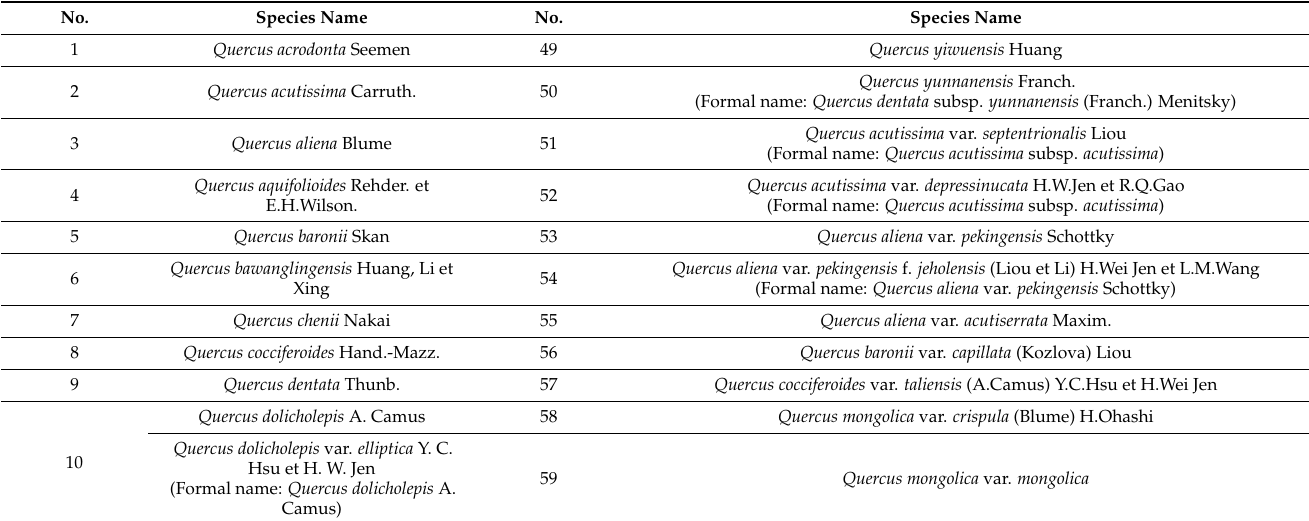
Table 1. Germplasm resources of oaks in